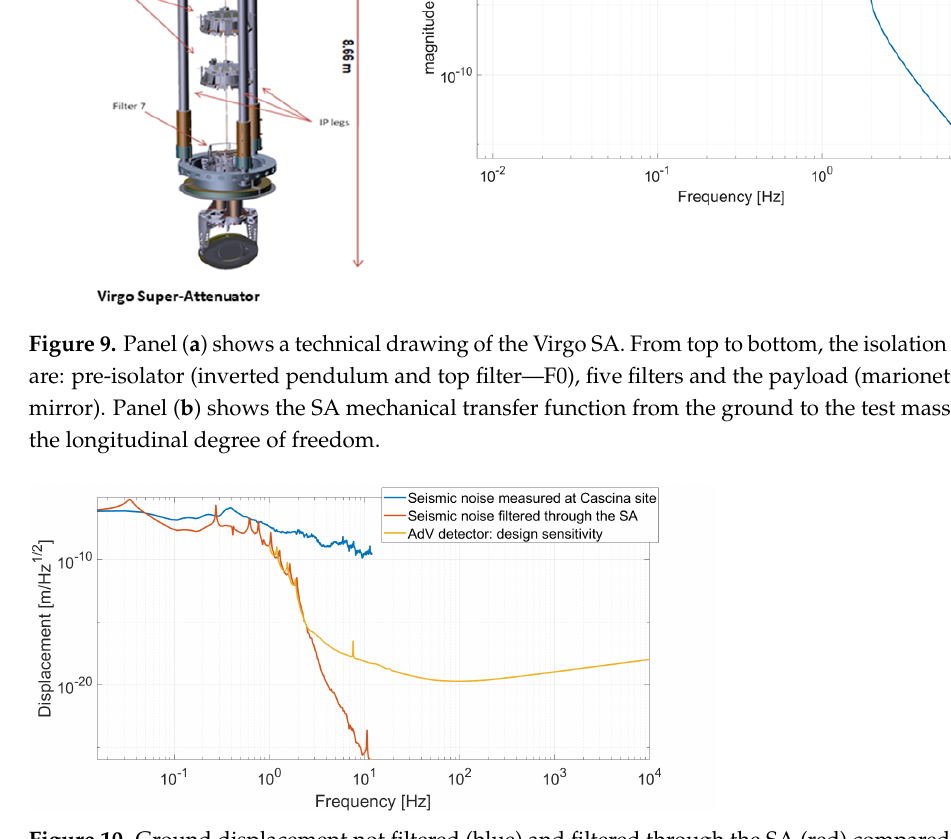
Figure 10. Ground displacement not filtered (blue) and filtered through the SA (red) compared to the design sensitivity of the AdV